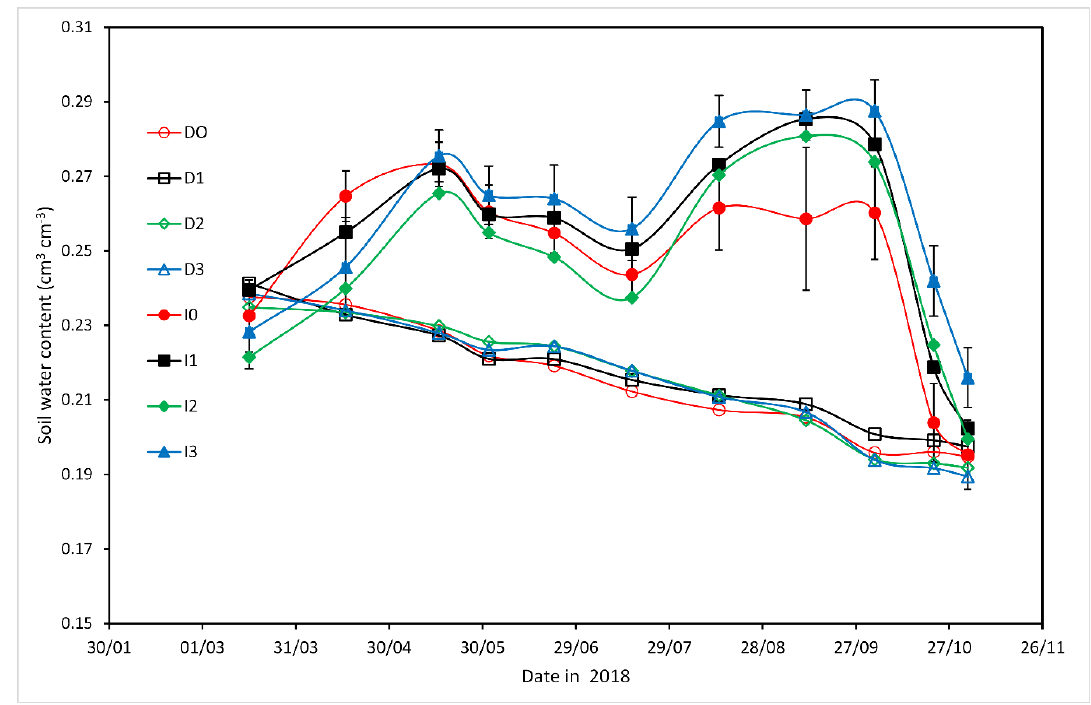
Figure 2. Average rootzone (120 cm) soil water content for unirrigated (D) and irrigated (I) treatments of winter wheat. D0 and I0 (“ungrazed”), D1 and I1 (“grazed” 31 May), D2 and I2 (grazed 25 July), and D3 and I3 (grazed 31 May and 25 July). Indicated are also standard error bars.